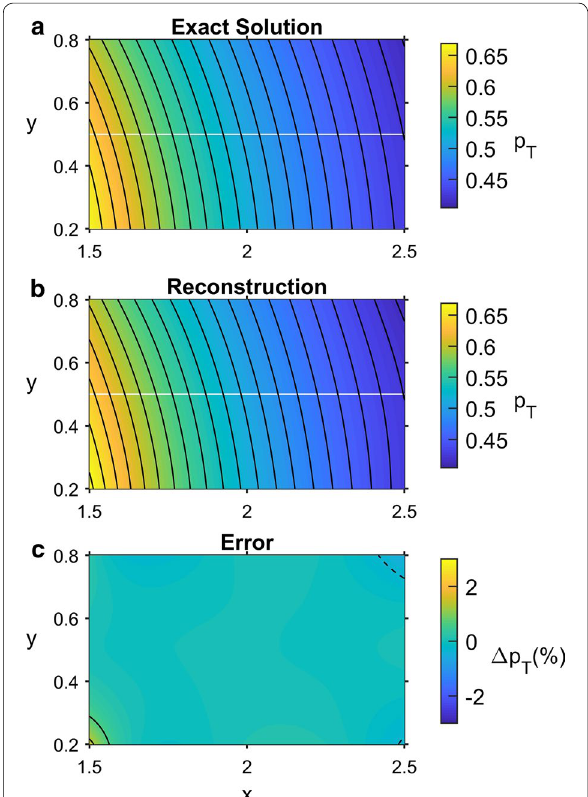
Fig. 2 a Analytic results for F z in contour lines and p T in color. b Reconstruction results in the same format. c Errors for F z in contour lines and p T in color. The solid and dashed curves represent positive and negative errors at 0.5% intervals